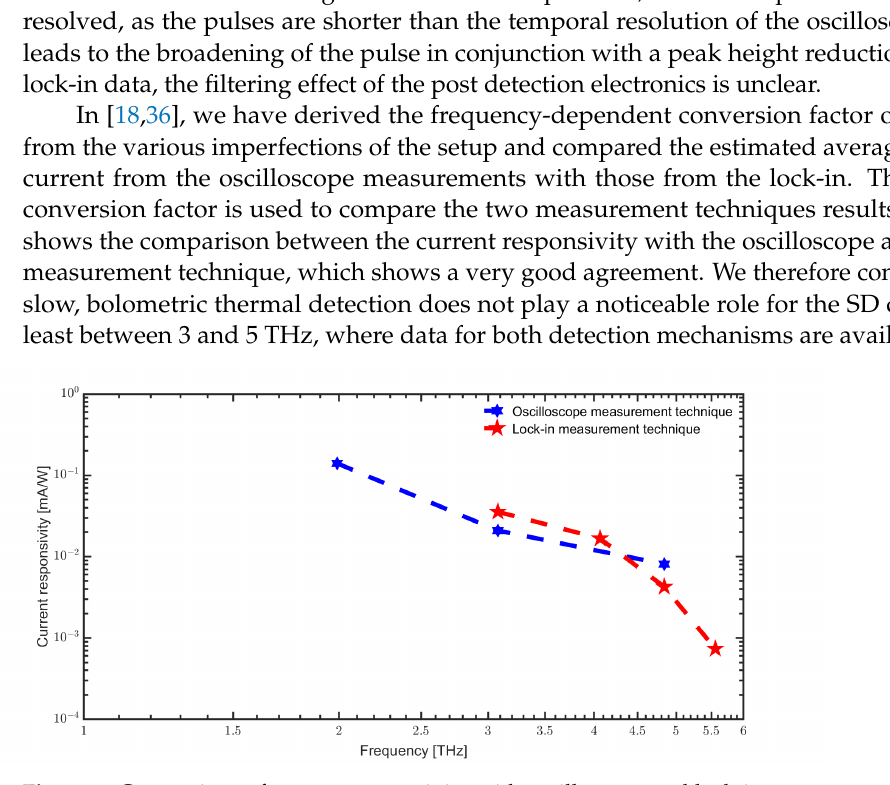
Figure 9. Comparison of current responsivity with oscilloscope and lock-in measurement technique (FELBE